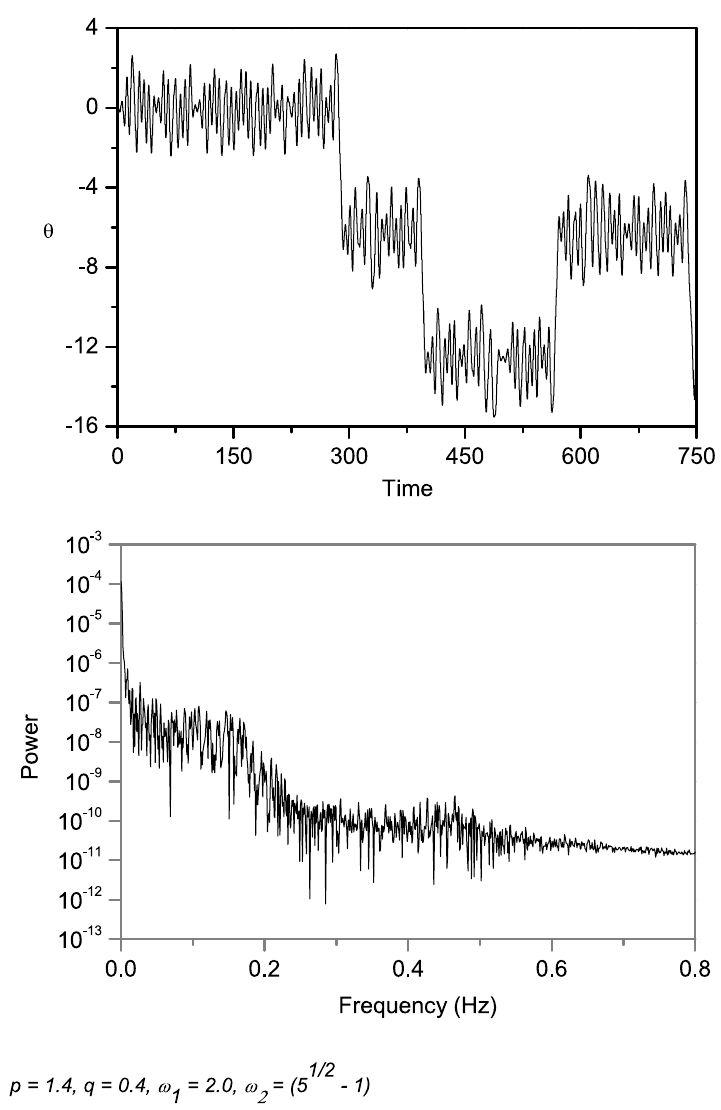
Figure 9. Time history and corresponding power spectrum of the chaotic motion based on numerical model with Equation (1). ω p = 1 . 4 , q = 0 . 4